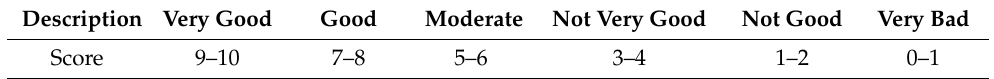
Table A3. Score evaluation